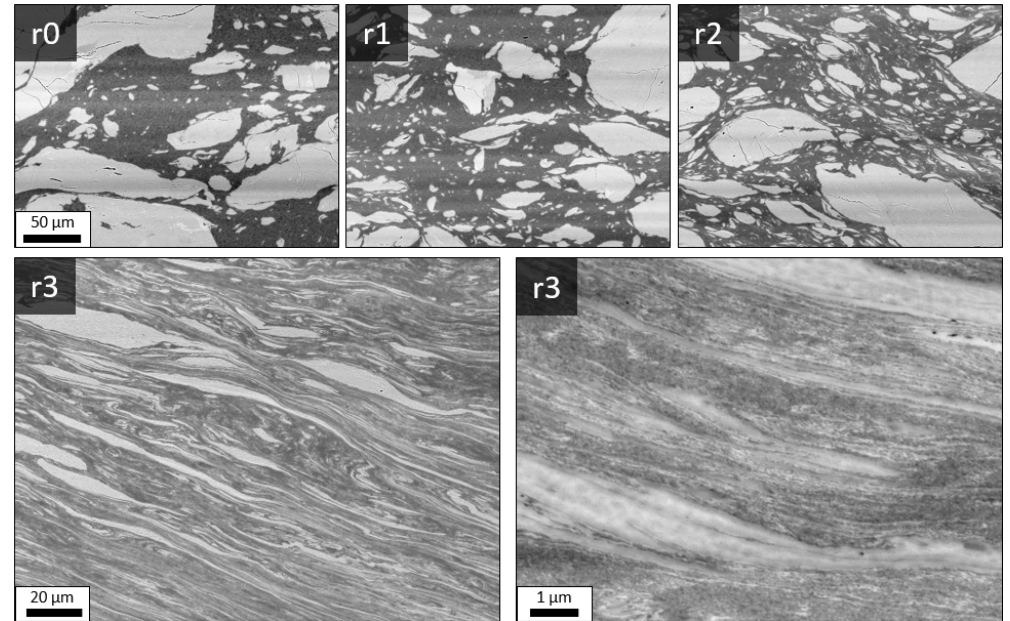
Figure A5. BSE images of a HPT-deformed sample (Nr. 6) at 400 ◦ C consisting of 47 wt.% Fe–53 wt.% SmCo 5 at different radii. The scale bar in r0 also applies to r1 and r2. Images of two magnifications are presented for